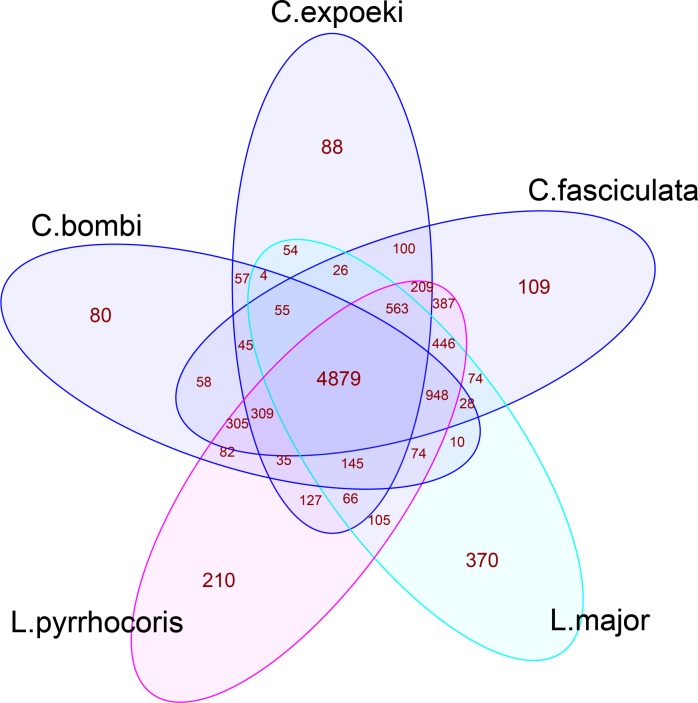
Venn diagram of orthologs.The Venn diagrams show the number of orthologs that are shared among a set of five species. Calculated with the OMA browser; matches of all types (1:1, many:1, 1:many, and many:many) are included.